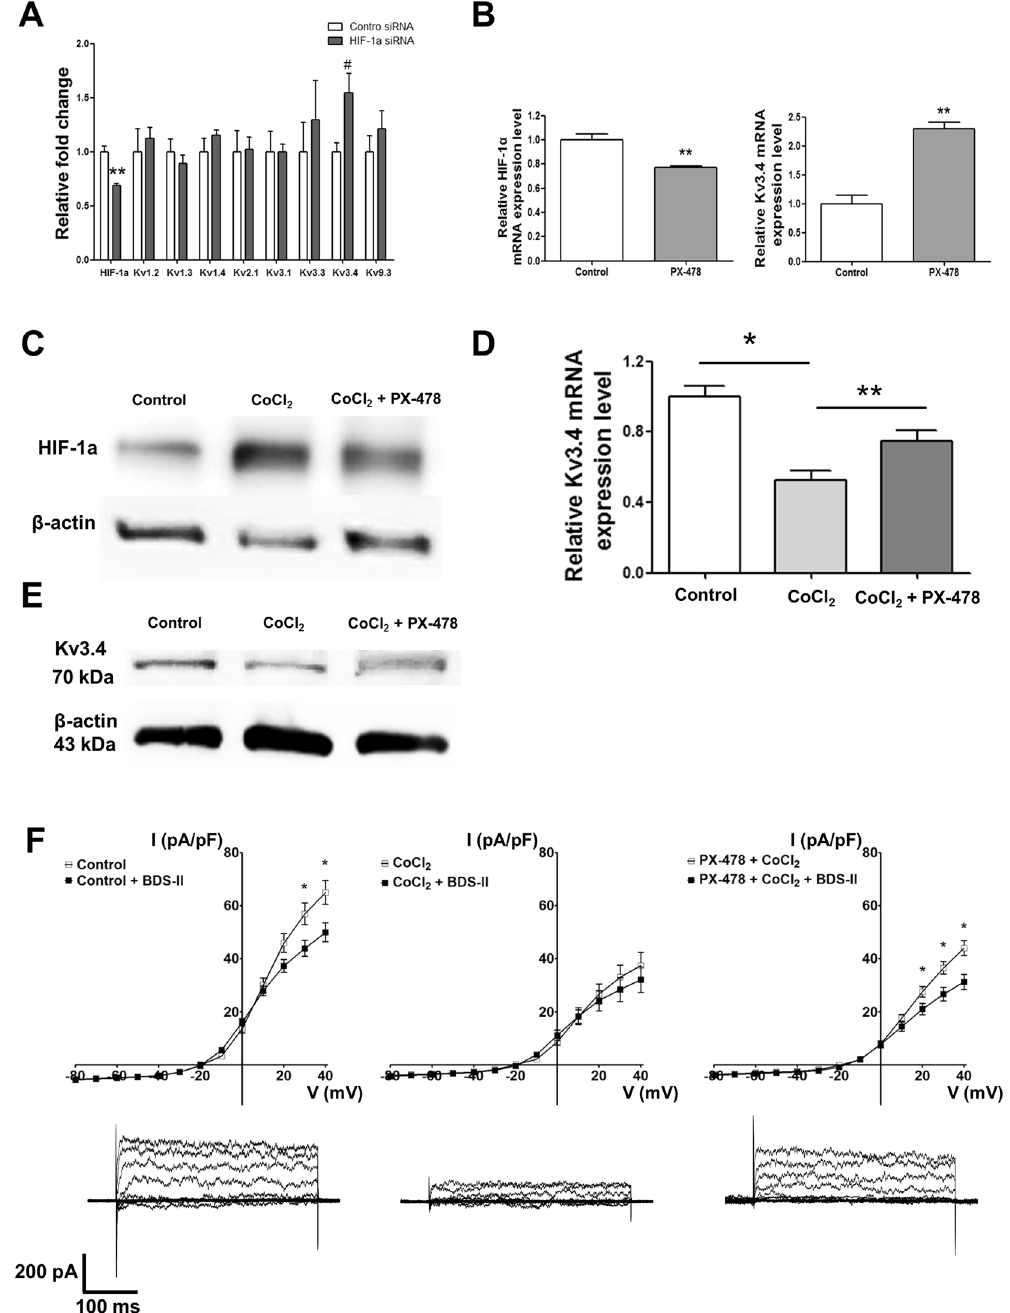
Figure 3. The relationship between HIF-1 α and Kv3.4 ( A ) Out of eight oxygen-sensitive Kv channels (Kv1.2, Kv1.3, Kv1.4, Kv2.1, Kv3.1, Kv3.3, Kv3.4, and Kv9.3), only Kv3.4 from among eight was significantly up-regulated by transient HIF-1 α siRNA transfection. ( B ) PX-478 (40 µ M), a HIF-1 α -specific blocker, inhibited HIF-1 α and up-regulated Kv3.4 mRNA expression. ( C ) HIF-1 α accumulated upon 100 µ M CoCl 2 treatment, and CoCl 2 -induced HIF-1 α accumulation was inhibited by 40 µ M PX-478 treatment: 4 h of PX-478 pretreatment followed by 6 h of CoCl 2 and PX-478 treatment. ( D ) Kv3.4 mRNA expression was down-regulated after 4 h of 100 µ M CoCl 2 treatment. PX-478 pretreatment recovered the down-regulation of Kv3.4 mRNA expression induced by CoCl 2 . ( E ) Kv3.4 (70 kDa) was decreased after 6 h of CoCl 2 treatment. The decrease in Kv3.4 (70 kDa) expression was recovered by PX-478 pretreatment (4 h) followed by 6 h of CoCl 2 and PX-478 treatment. ( F ) Currents sensitive to BDS-II (100 nM) were detected at + 30 and + 40 mV of depolarization (n = 6), whereas BDS-II-sensitive currents were diminished by 100 µ M CoCl 2 treatment (n = 6). Diminished BDS-II-sensitive currents were recovered by 40 µ M PX-478 pretreatment at + 20, + 30, and + 40 mV of depolarization (n = 9). Experiments were repeated in triplicate or the indicated times, and data represent the mean ± standard error. * , # p < 0.05 and ** p < 0.01 versus the control